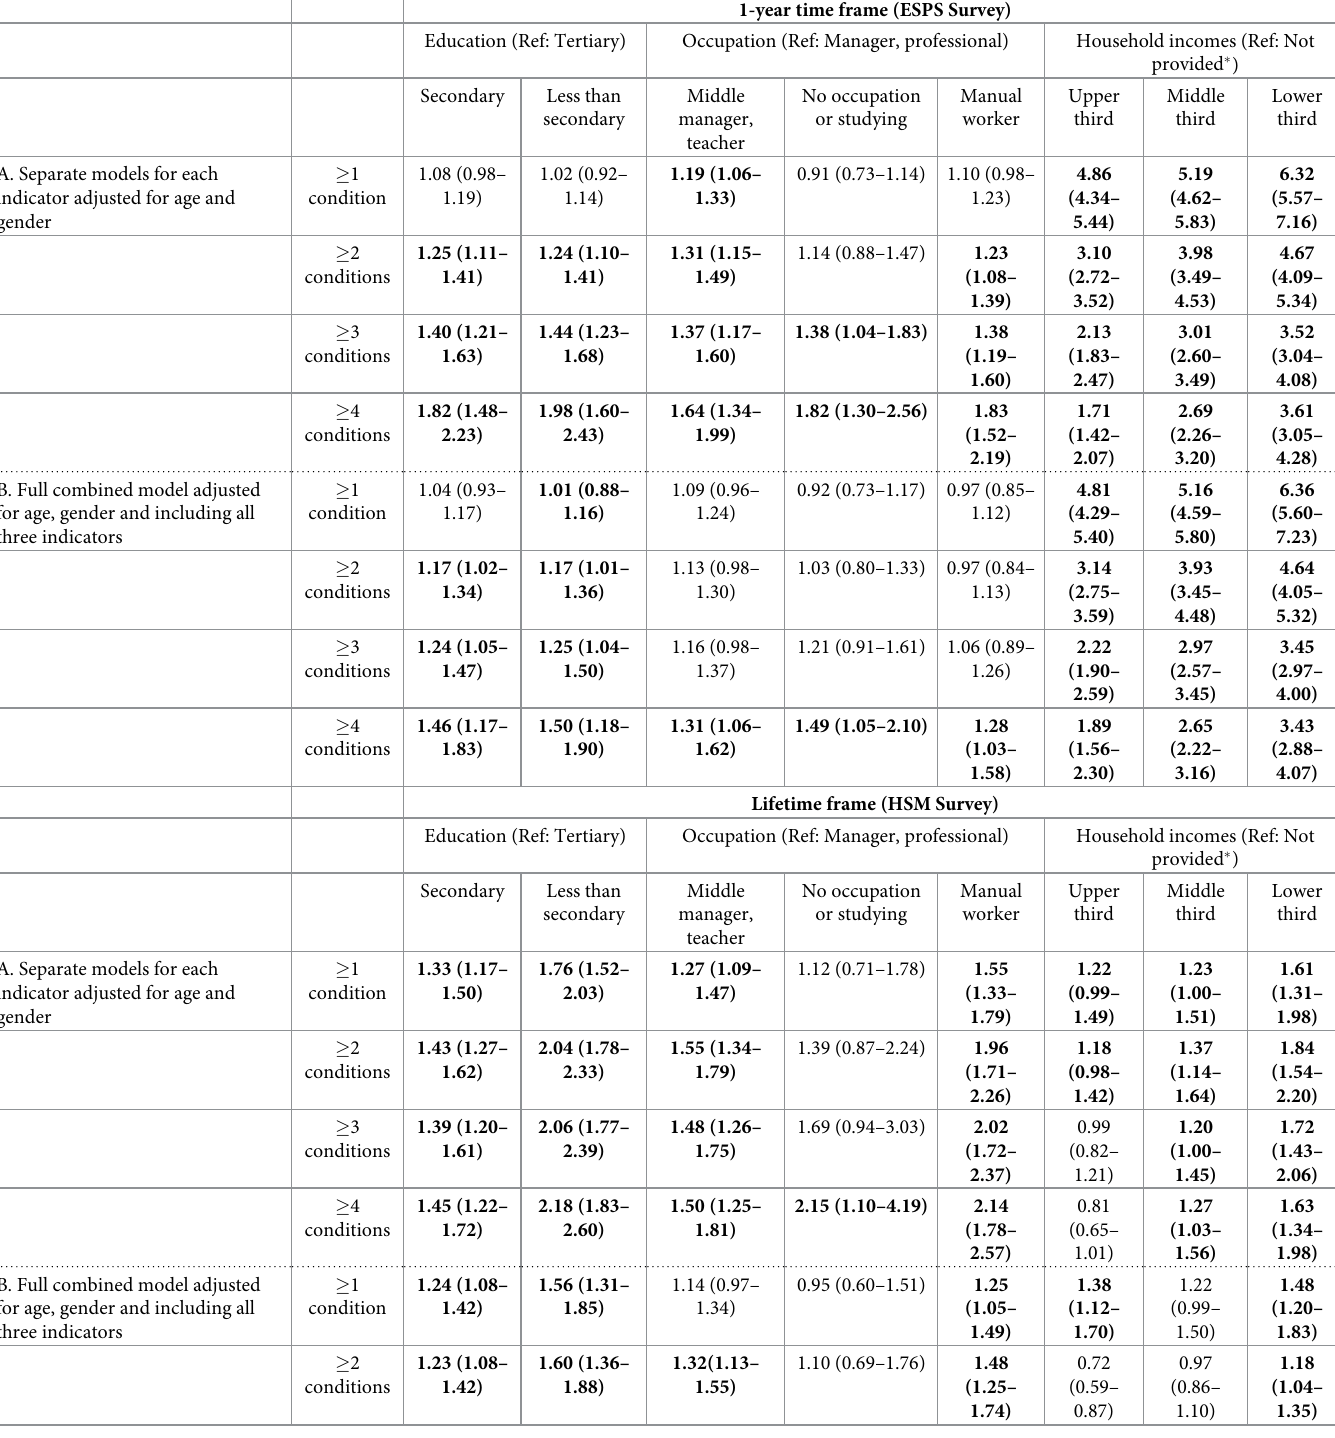
Table 4. Age and gender adjusted risk of having more than 1, 2, 3 and 4 conditions, associated with each separate (upper panel) or with the three socioeconomic sta- tus indicators (education level, occupation, and household income) (lower panel) as estimated in multiple binary logistic regression (full